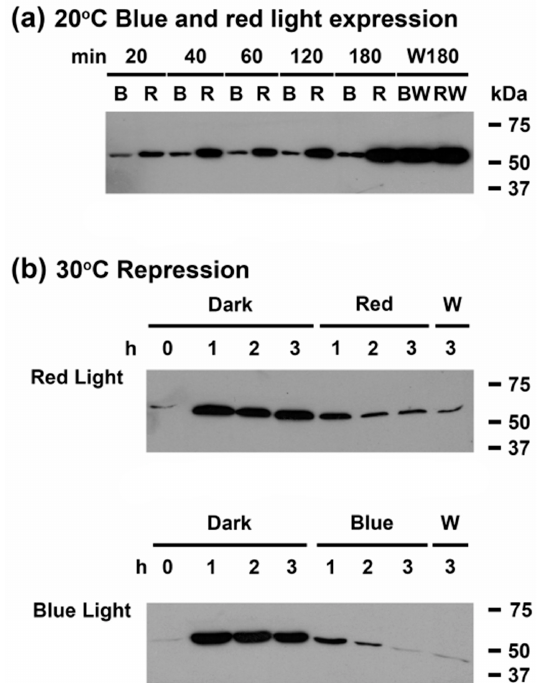
Figure 5. Red light is required for CrhR protein accumulation. Wild type Synechocystis cells were grown to mid-log phase at 30 ◦ C and the effect of varying light quality on CrhR induction and proteolysis was analyzed in conjunction with temperature downshift and upshift by Western blotting. ( a ) Effect of light quality on low temperature induction. Cells grown at 30 ◦ C under white light conditions were transferred to 20 ◦ C in either blue (B) or red (R) light and sampled for 3 h at indicated time points. Cells were subsequently transferred to white light for 3 h (W180; BW, RW) to test for maximal CrhR accumulation. Protein derived from blue (B)- or red (R)-light treated cultures are displayed in adjacent lanes to aid visualization of the effects. ( b ) Effect of light quality on temperature upshift induced repression. Cells were grown at 30 ◦ C under white light conditions (T = 0) before pre-induction at 20 ◦ C for 3 h to induce maximal CrhR accumulation. Cells were subsequently returned to 30 ◦ C in the dark and sampled every hour for 3 h. Cultures were then transferred to either red or blue light at 30 ◦ C and sampled every hour for 3 h. Finally, the cultures were maintained at 30 ◦ C and transferred to white light (W) to test for maximum CrhR repression (W3). CrhR protein abundance was determined by Western blotting, as described in Figure